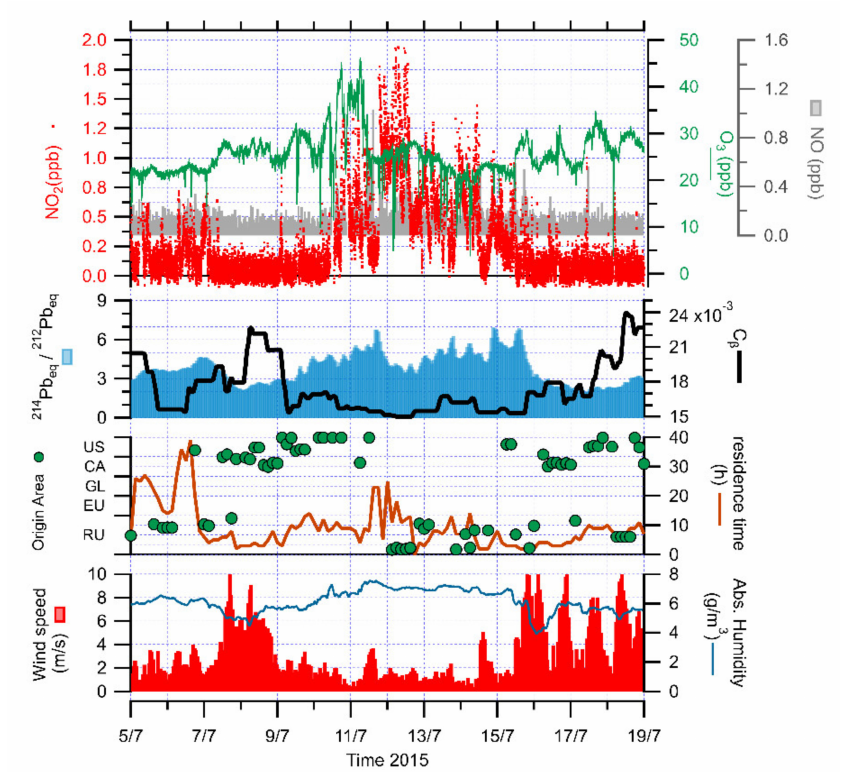
Figure 6. Time series of NO, NO 2 and O 3 concentrations, together with isotopic composition of radon progeny (short-lived progeny/long-lived progeny ratio, 214 Pb eq / 212 Pb eq , and very-long-lived component, C β ), origin (US—NW United States; CA—Canada; GL—Greenland; EU—NW Europe; RU—Russian Federation) and residence time of air masses, wind speed and the absolute humidity during the biomass burning event in July 2015 at